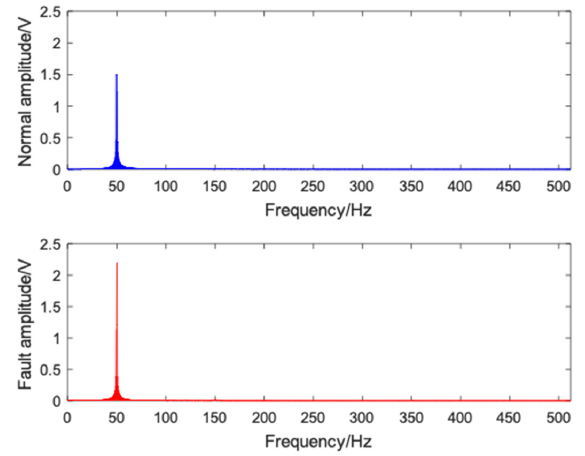
Figure 3. Spectrum diagrams of the collected current signals.